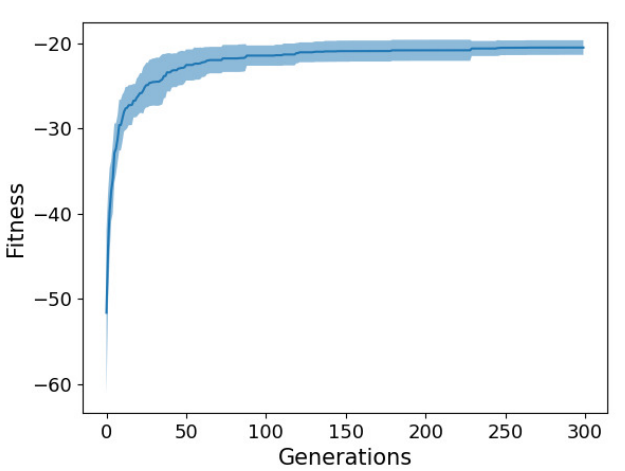
Figure 3. Fitness across generations (mean ± std. dev. across 10 independent runs) for SNPS (5) on CMAPSS